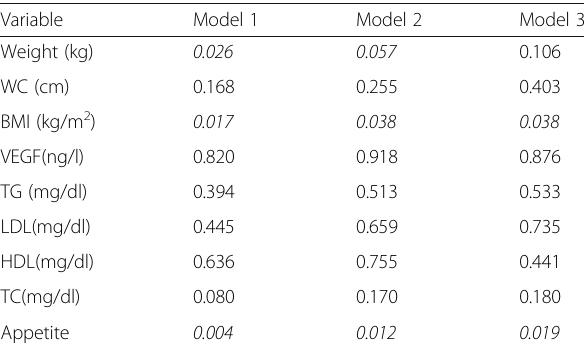
Table 5 The comparison of studied variables between study groups after adjusting for possible